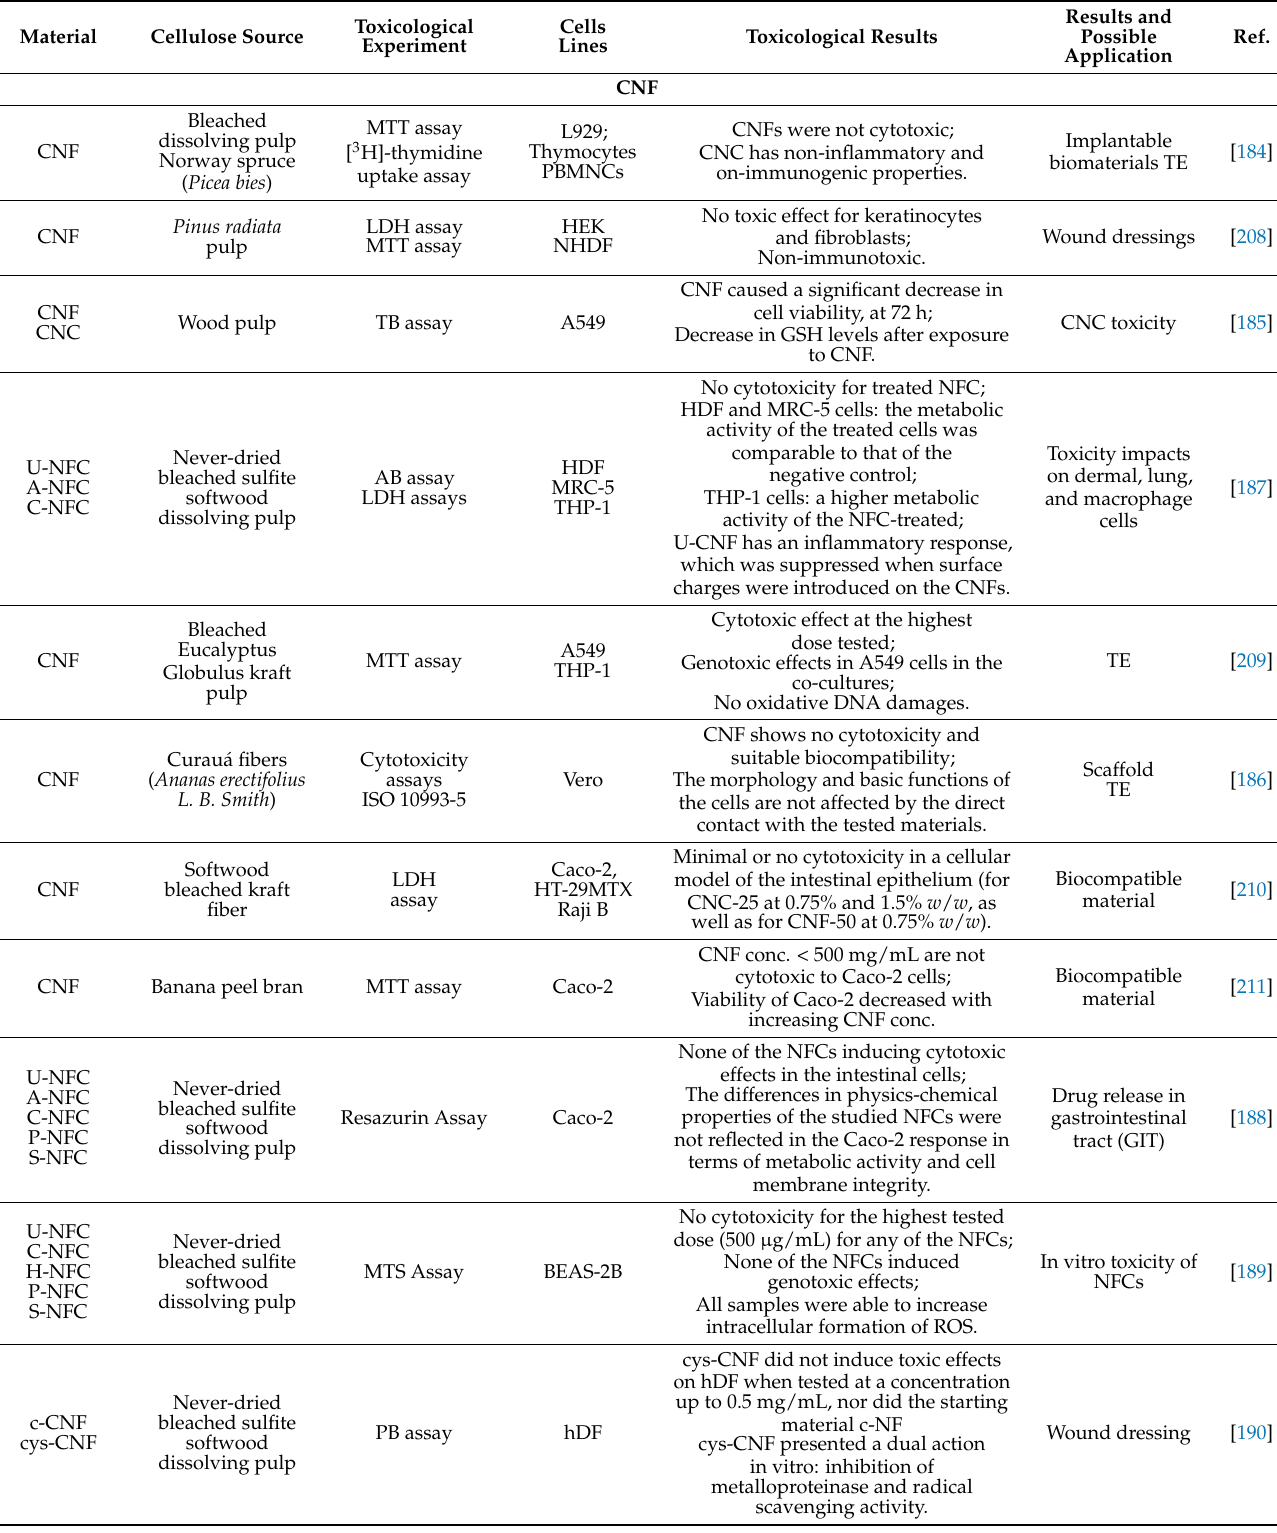
Table 5. Cytotoxicity evaluations in in vitro studies induced by CNF- and CNF-based materials.